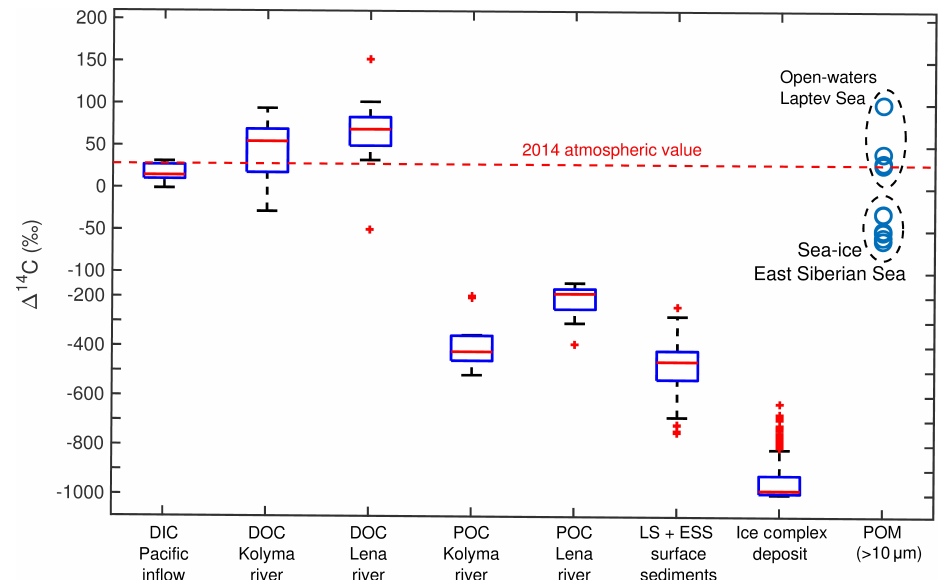
Figure 6. Radiocarbon signature of inorganic and organic carbon pools. Whisker plots of radiocarbon values for different inorganic and organic carbon sources from the literature, compared to the outer Laptev Sea and outer East Siberian Sea (blue circles, this study). Solid lines show the median, the box limits display the 25th and 75th percentiles, and the crosses show the outliers. Source: DIC (Griffith et al., 2012), DOC-Kolyma (2009–2014), DOC-Lena (2009–2014), POC-Kolyma (2009–2011), POC-Lena (2009–2011) (http://www.arcticgreatrivers. org), Laptev Sea and East Siberia Sea surface sediments (Salvadó et al., 2016; Vonk et al., 2012) and ICD (Vonk et al.,